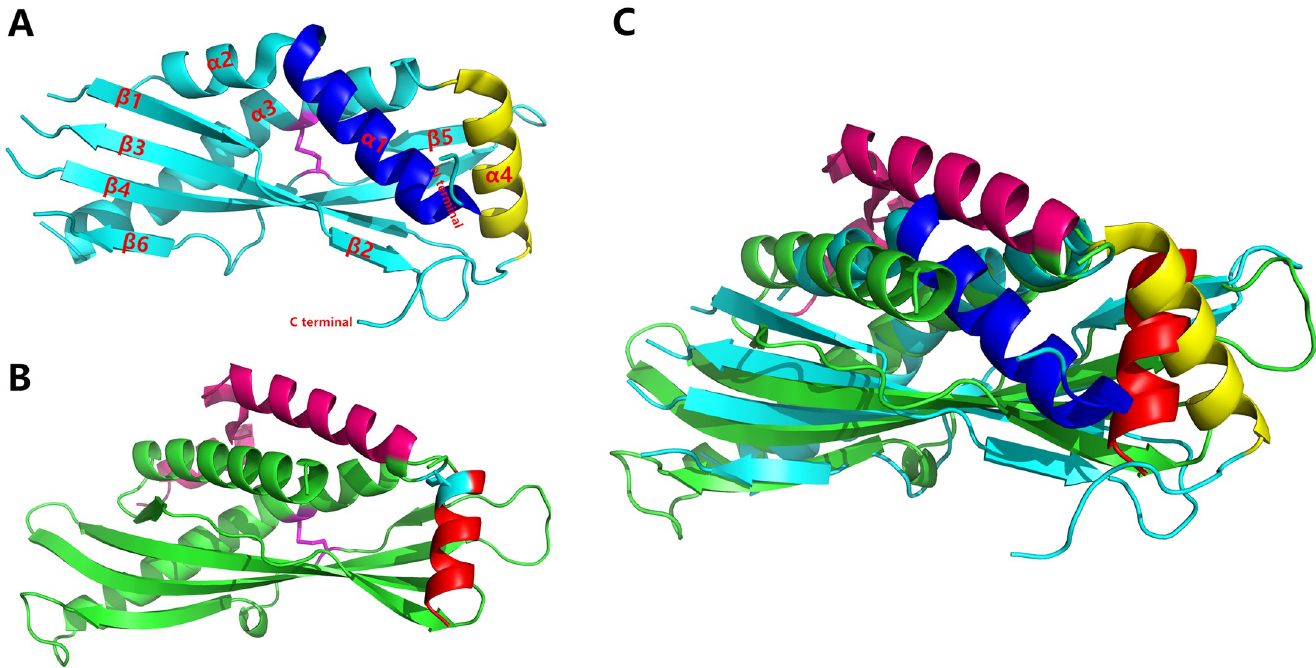
Fig 2. Structural comparison between BSP30b with hSPLUNC1. (A) the structure of hSPLUNC1, with its disulfide bond shown in magenta. (B) the structure of BSP30b. The conserved disulfide bond is shown in magenta and the second disulfide bond is shown is cyan. (C) structural alignment of BSP30b to hSPLUNC1. BSP30b is shown in cyan and hSPLUNC1 is shown in green. Their structural differences are marked with different colours as per A and B.